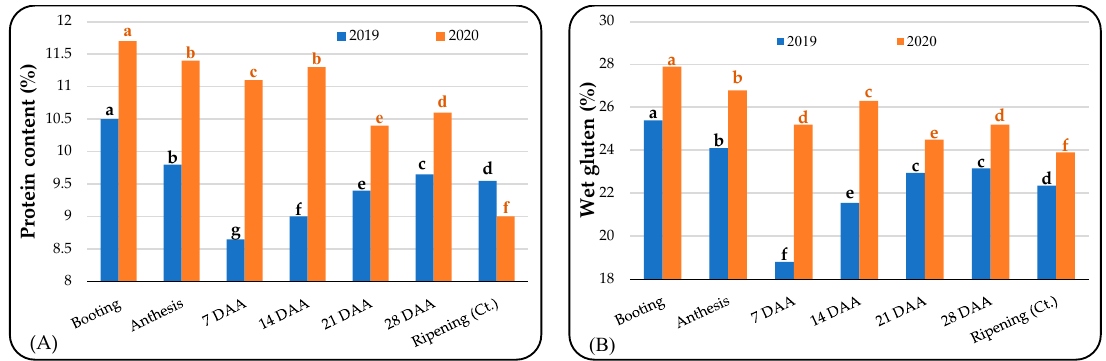
Figure 6. The variation of grain-quality indices (( A ) protein content; ( B ) wet gluten content) under different flag leaf removal stages in Andrada variety. Different letters in ( A ) and ( B ) figures, the significance is represented according to Duncan Test.